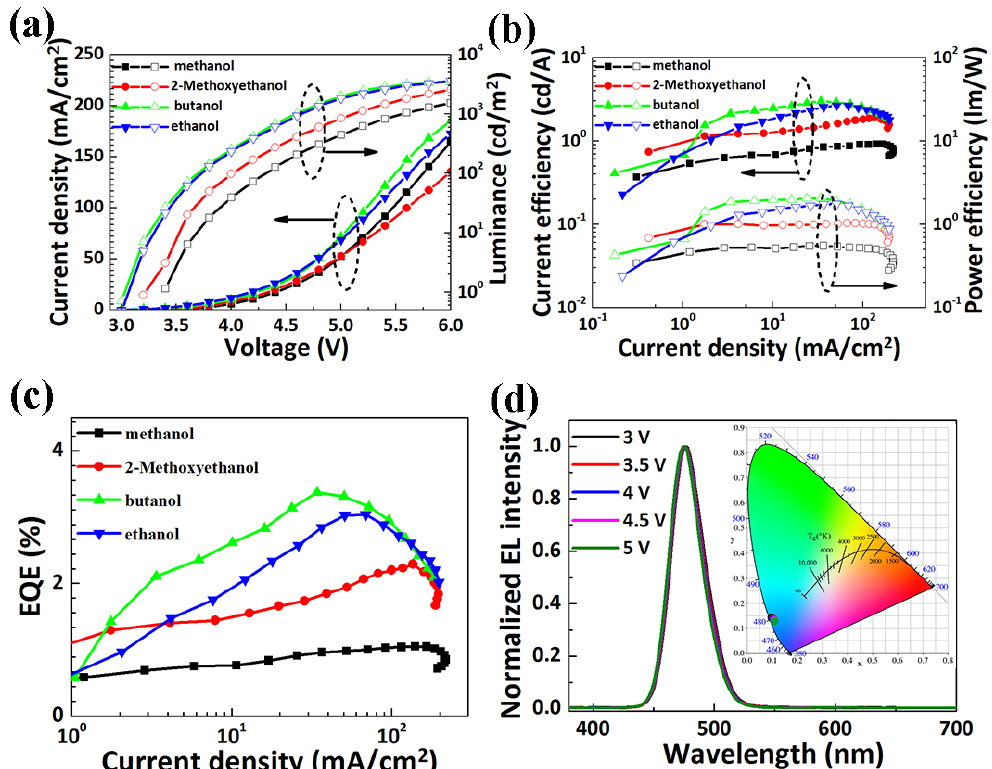
Figure 3. ( a ) Current density and luminance-voltage characteristics of the QLED with ZnO NPs dispersed in different solvents; ( b ) Current efficiency and power efficiency, and ( c ) EQE of QLED device with ZnO NPs dispersed in different solvents; ( d ) Normalized EL spectra of QLEDs with butanol. Inset shows the CIE coordinate of the device under different driving voltage. Table 1. Summary of turn-on voltage, driving voltage, EQE, current efficiency, and power effi- ciency data of the QLED Device based on ZnO NPs dispersed in different solvents.